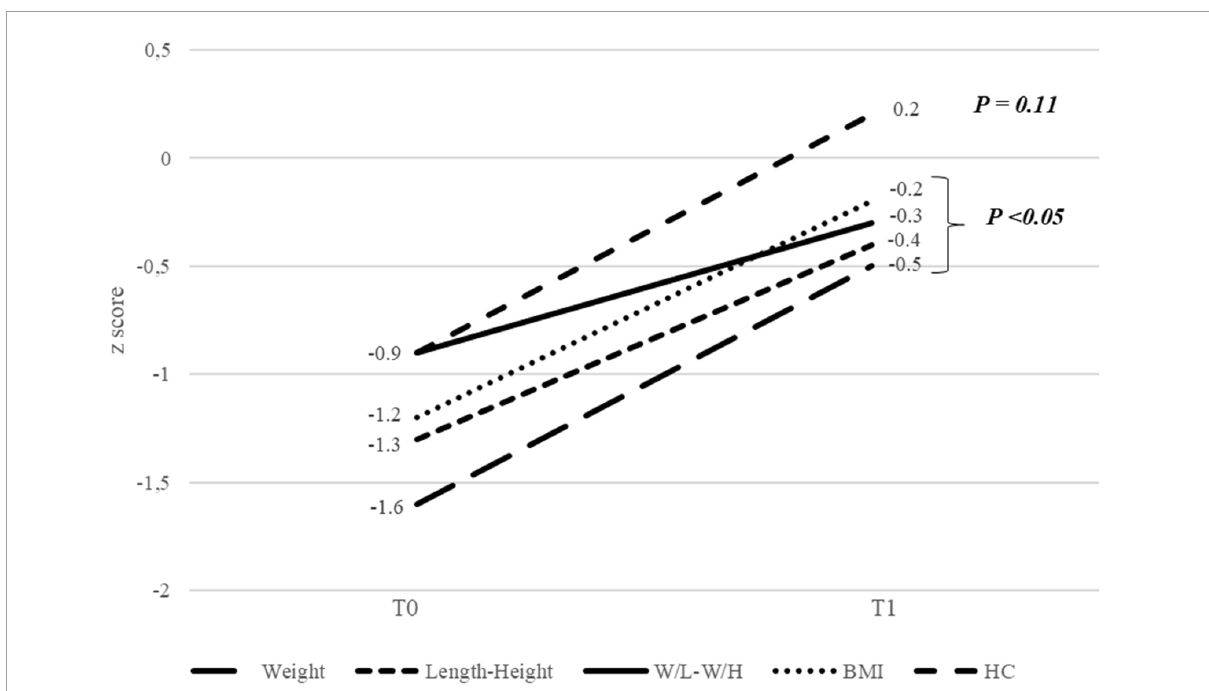
FIGURE2 Evolution of anthropometric parameters between the start (T0) and end (T1) of enteral nutrition. W/L, weight for length; W/H, weight for height; BMI, body mass index; HC, head circumference.